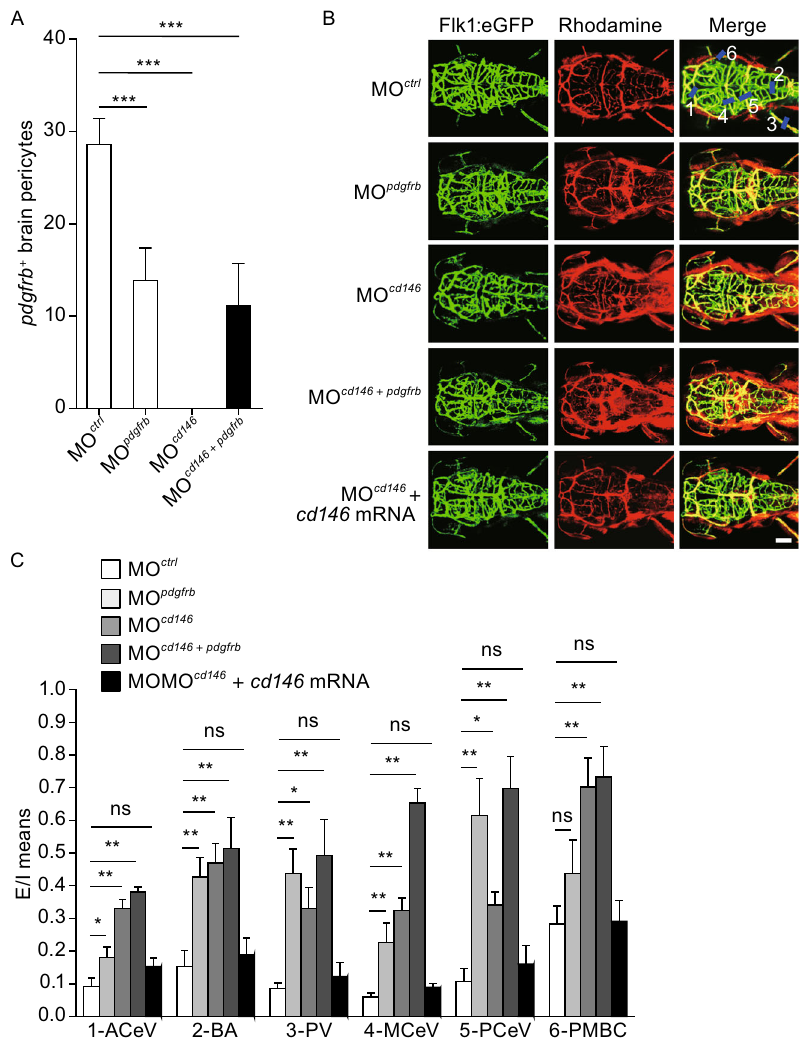
Figure 2. Knockdown of cd146 impairs BBB integrity and pericyte recruitment via PDGF-B signaling in zebra fi sh . (A) Quanti fi cation of pdgfrb + pericytes attached to cerebrovascular walls in zebra fi sh injected with cd146 morpholino, pdgfrb morpholino, or co-injected with cd146 and pdgfrb morpholinos. (B) Cerebral microangiography to analyze the BBB permeability of the 72 hpf zebra fi sh larvae injected with cd146 morpholino, pdgfrb morpholino, or co-injected with cd146 and pdgfrb morpholinos or with cd146 morpholino and cd146 mRNA. Scale bar represents 100 μ m. (C) Quanti fi cation of the Rhodamine signal for the intensity value of the vasculature lumen (I) relative to that out of the cerebral vasculature (E) in different central nervous system vessels of zebra fi sh injected with morpholinos as indicated. For each analyzed vessel, fi ve positions along the vessel were chosen for calculating the E/I value; * P < 0.05, ** P < 0.01, *** P < 0.001. Data represent fi ve independent experiments. ACeV, anterior (rostral) cerebral vein; BA, basilar artery; PV, pectoral vein; MCeV, middle cerebral vein; PCeV, posterior (caudal) cerebral vein; PMBC, primordial midbrain